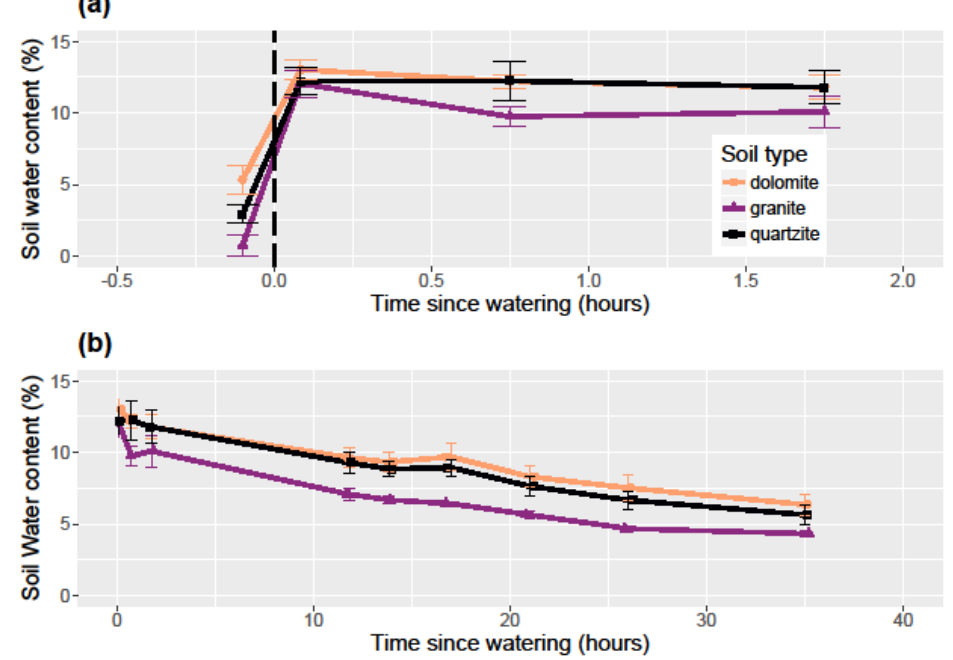
Figure 2. Water content as a function of time over the first two hours of the experiment ( a ) and over the entirety of experiment ( b ). The graph in ( a ) is a zoomed-in version of ( b ) for more clarity in the earliest time periods and also includes the water content measurement prior to experimental watering. Error bars are 1 standard error of the mean soil water content.